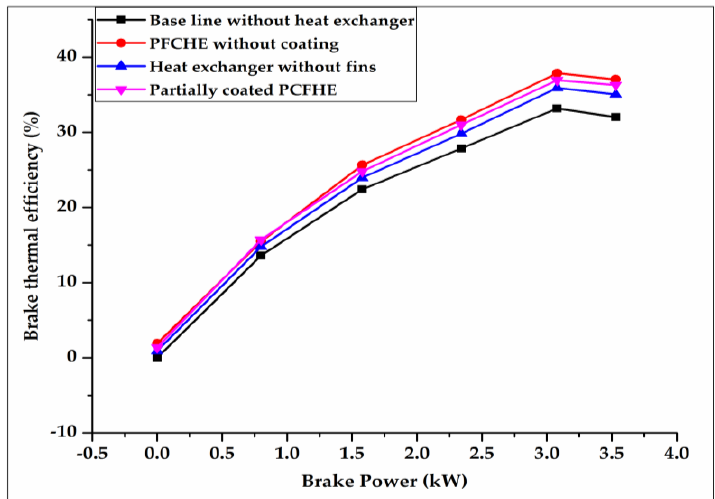
Figure 7. Effectiveness of heat exchanger with fin geometry.